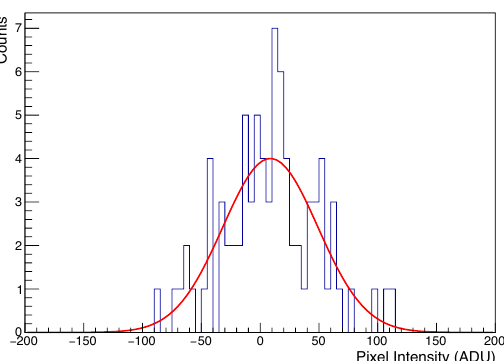
Figure 14. The intensity distribution of pixels within the source box for a single